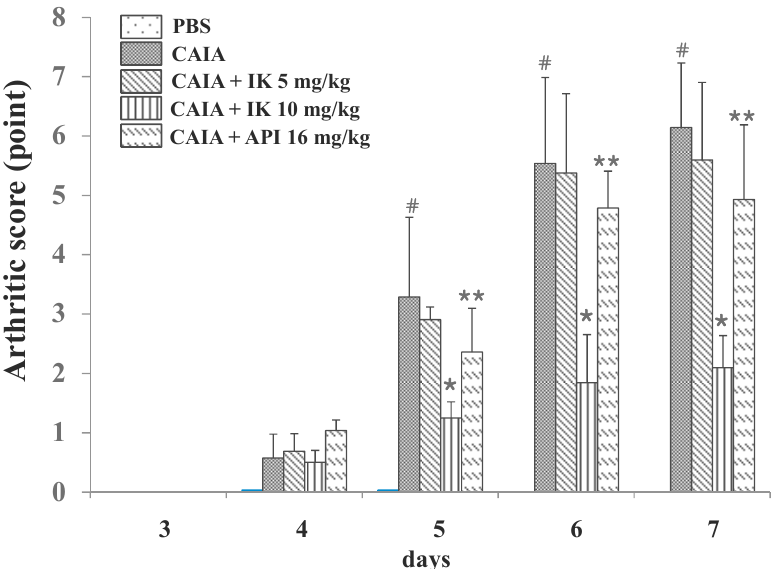
Figure 5. Effect of IK and API on arthritic score in CAIA mice. Arthritic score was done blindly by using a system based on the number of inflamed joints in front and hind paws, inflammation being defined by swelling and redness at the scale from 0 (no redness and swelling) to 3 (severe swelling with joint rigidity or deformity; maximal score for four paws, 12). Data are presented as means ± SD ( n = 6). # p < 0.05 vs. PBS-group, * p < 0.05 vs. CAIA-group, and ** p < 0.05 vs. IK(10 mg/kg)-group.